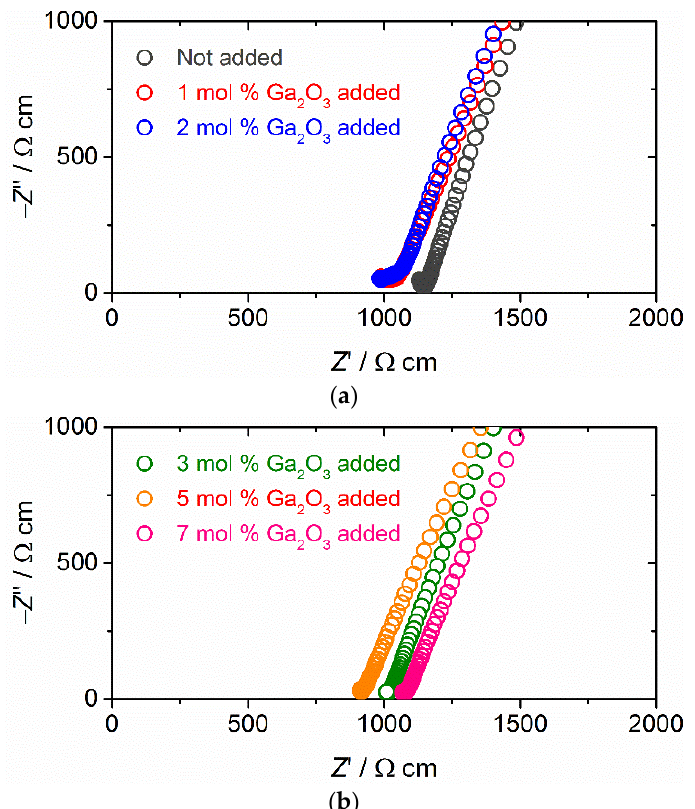
Figure 4. Nyquist plots for complex impedance Z ’ + j Z ” in Ta-doped LLZO sintered with or without Ga 2 O 3 addition measured at 27 °C: ( a ) 0, 1 and 2 mol % Ga 2 O 3 addition and ( b ) 3, 5 and 7 mol % Ga 2 O 3 addition. Au ionic blocking electrodes were used for the measurement.